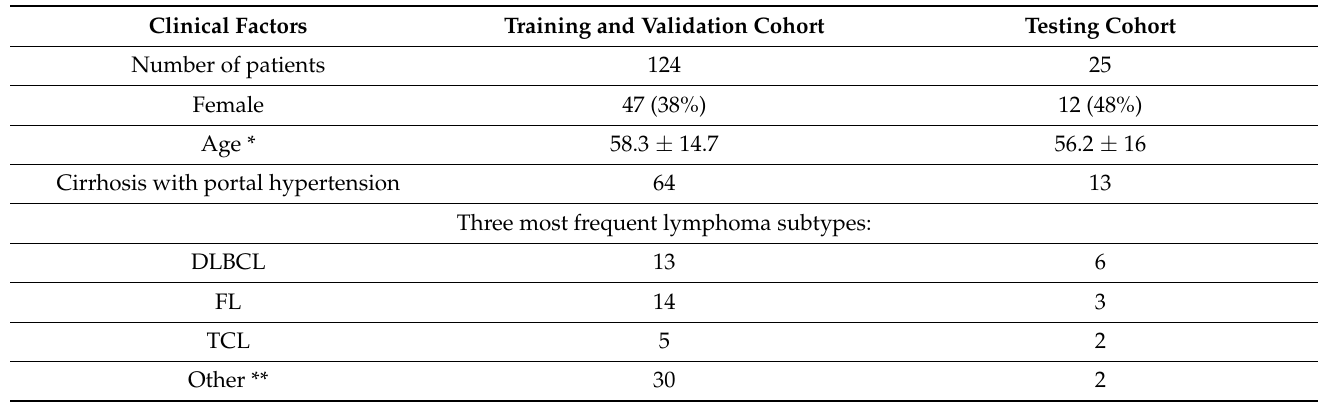
Table 1. Clinical factors of the training, validation, and testing cohorts. Unless otherwise indicated, data are expressed as the number of participants.